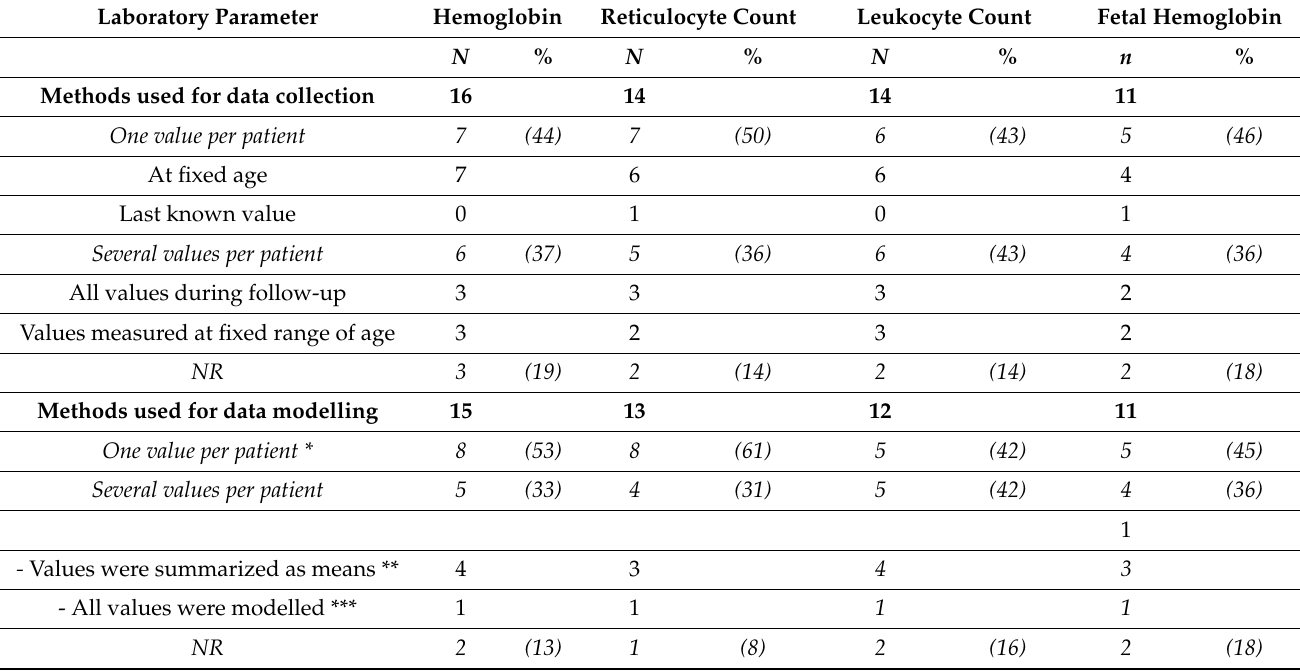
Table 2. Description of the methods used to collect and to analyze biological parameters in the 16 SCD cohort studies. Laboratory Parameter Methods used for data